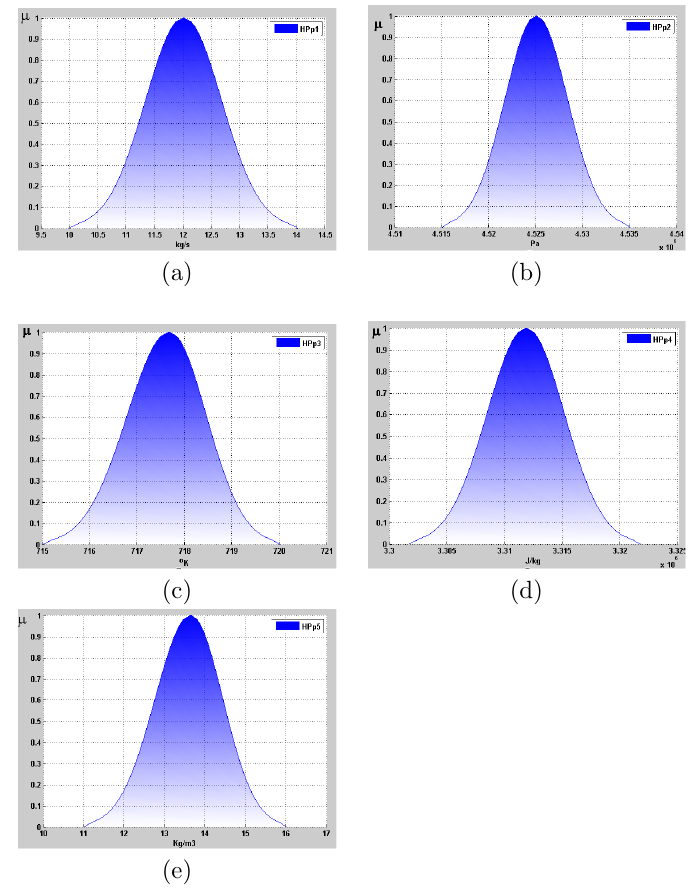
Figure 2. Fuzzy input parameters of high-pressure section of a steam turbine system (a) p 1 (Inlet steam flow from boiler superheat section), (b) p 2 (Inlet steam pressure), (c) p 3 (Inlet steam flow temperature), (d) p 4 (Inlet steam flow enthalpy) and (e) p 5 (Inlet steam flow